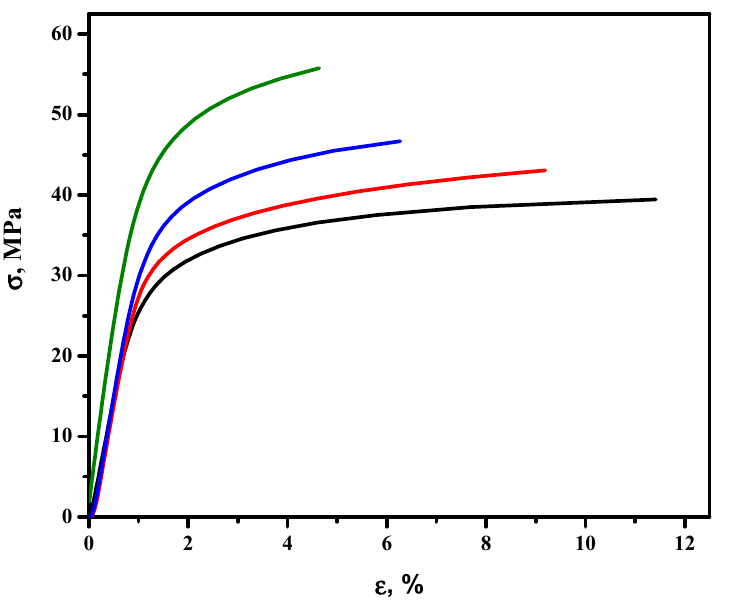
Figure 5. Stress vs. strain curves of the PLA and the composites with different loads (0.3, 1, 5 wt.%) of MXene particles. PLA sample corresponds to the black line, PLA + 0.3 wt.% of MXene to the red line, PLA + 1 wt.% of MXene to the blue line and PLA + 5 wt.% to the green line.